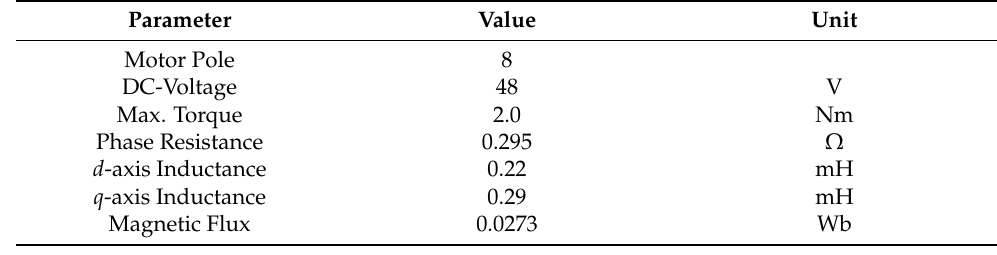
Table 2. Motor parameter values.